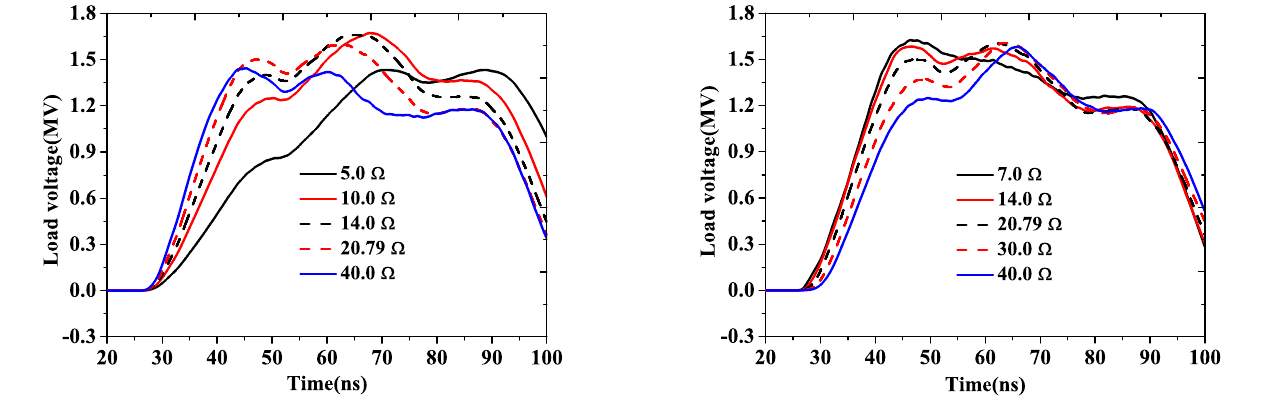
FIG. 10. Load voltage waveforms with different output trans- mission line impedance obtained by 2D circuit simulation.